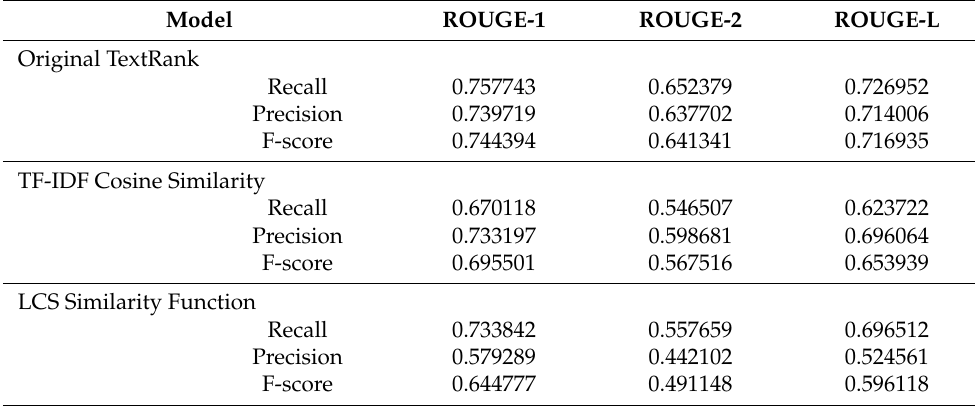
Table 2. Comparison analysis of various methodologies using medium article